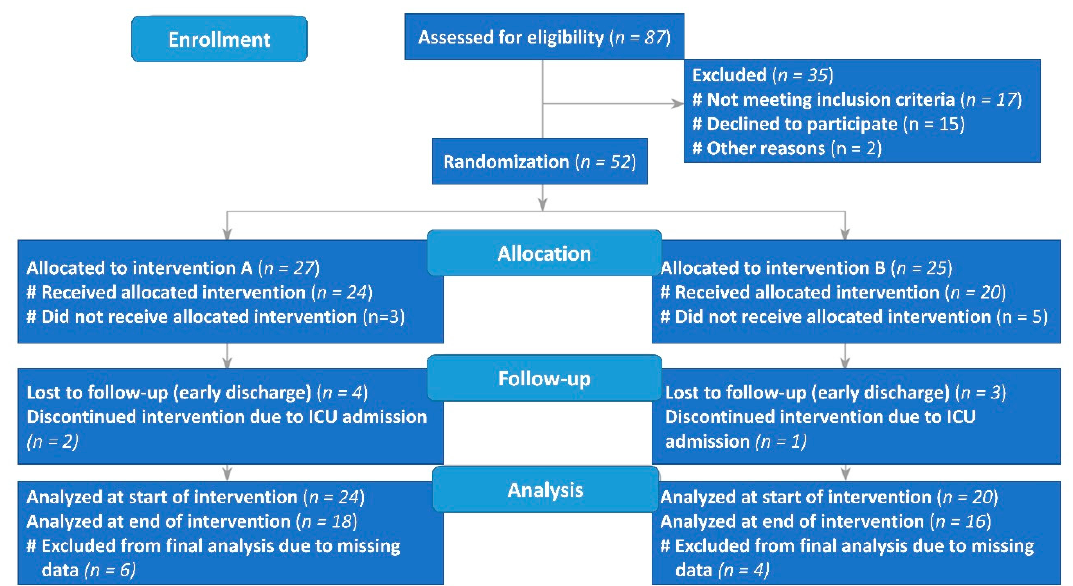
Figure 1. Flow diagram of the progress through the phases of the controlled randomized trial.